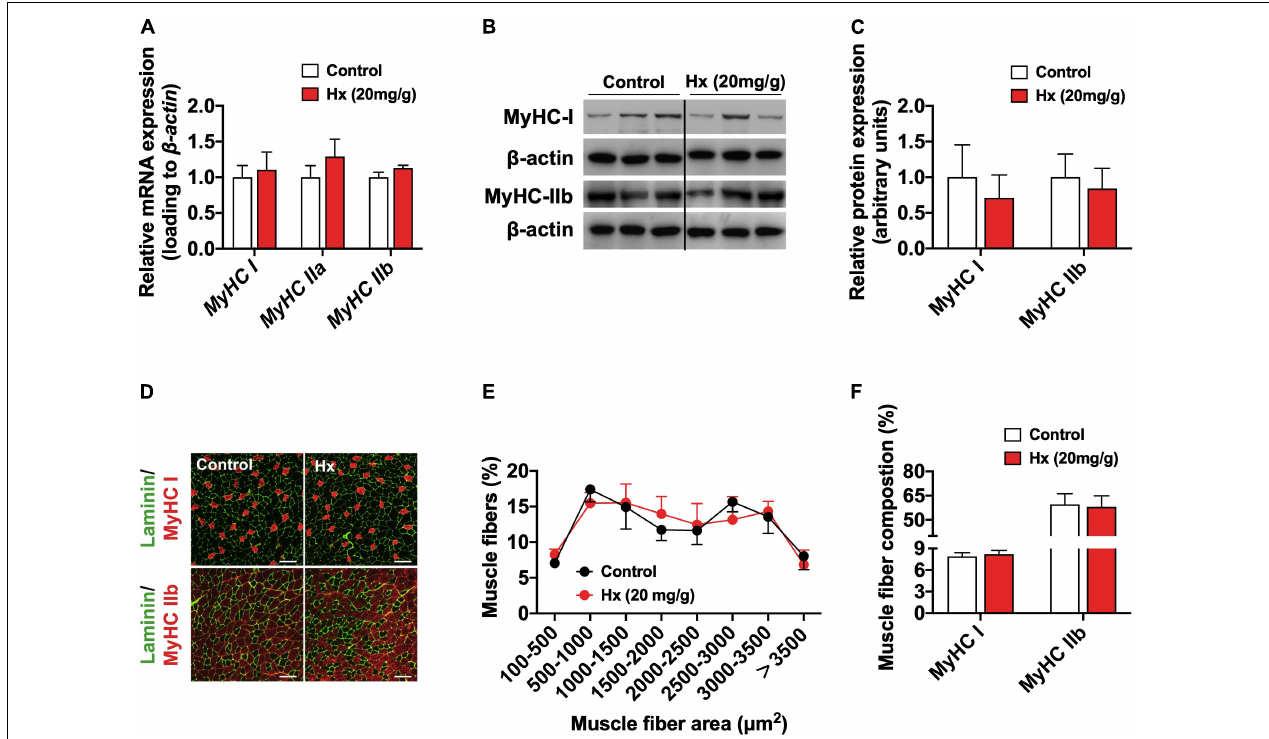
FIGURE 2 | Chronic Hx-treated does not alter muscle fiber area and fiber type composition. (A) mRNA expression of genes related to the myofiber types ( n = 8–10 mice per group). (B,C) Western blot (B) and quantification (C) of MyHC I and MyHC IIb content in the GAS muscle ( n = 6 per group). Dividing lines indicate spliced bands from the same gel. (D) Immunofluorescence staining of Laminin (green), MyHC I (upper, red), and MyHC IIb (lower, red) of GAS muscle section (bars = 50 µ m). (E,F) Statistical analysis of muscle fiber area (E) and fiber type composition (F) according to immunofluorescence staining of muscle sections ( n = 3 mice per group). β -actin was used as loading control both in qRT-PCR and western blot. Values are presented as means ±